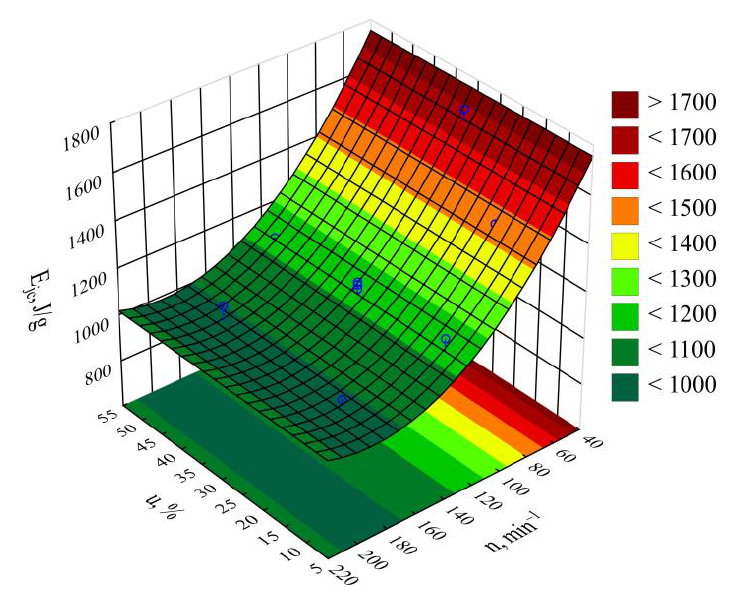
Figure 9. Response surface graph for the extruder’s specific energy consumption E jc versus the screw rotational speed n and bran mass fraction u.